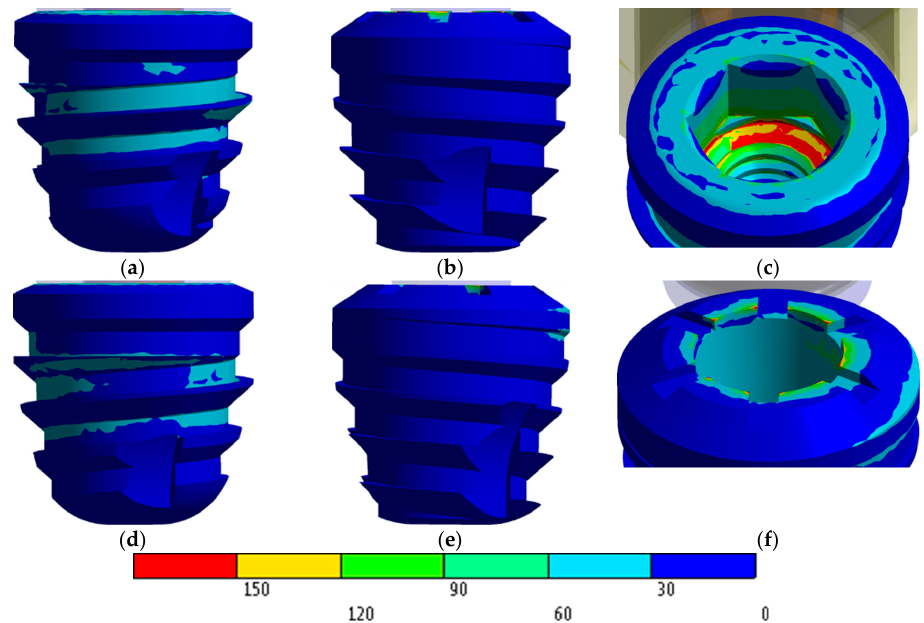
Figure 8. von Mises stress distribution in MPa: ( a ) IH vestibular view; ( b ) IH distal view; ( c ) IH stress concentration; ( d ) MT vestibular view; ( e ) MT distal view; ( f ) MT stress concentration. Stress concentrations on the IH implant are observed in the region of the first threads for the implant platform (Figure 8f).